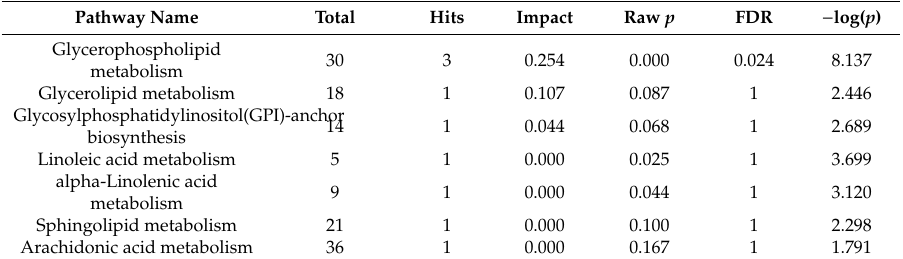
Table 2. Metabolic pathway analysis with MetaboAnalyst from differential lipid species.